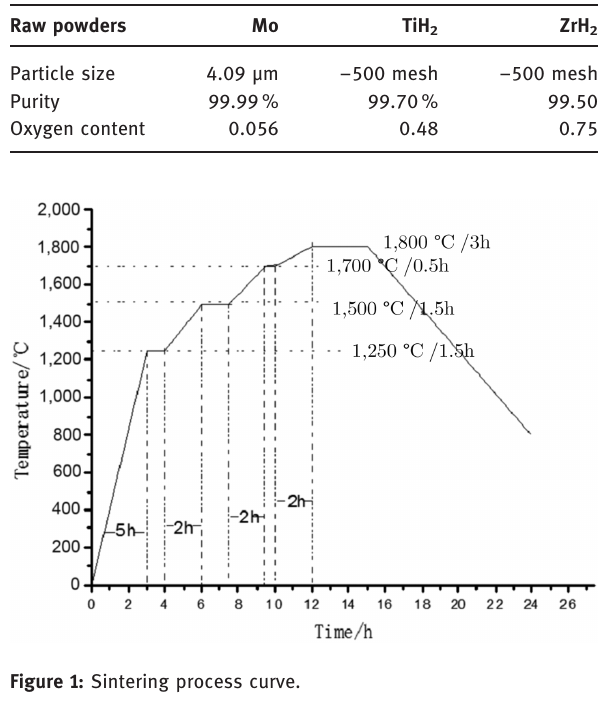
Figure 1: Sintering process curve.